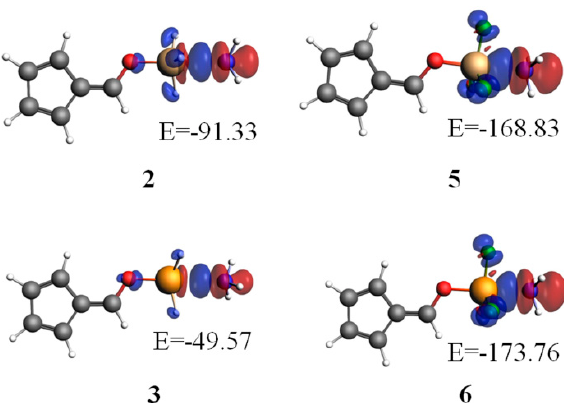
Figure 4. Plots of deformation densities of the pair-wise orbital interactions ( Δρ ) in 6-OTX 3 -fulvene ··· NH 3 (T = Si, Ge; X = H, F) at the PBED3/TZ2P//MP2/aug-cc-pVTZ level. The associated orbital interaction energies are given in kJ/mol. The color code of the charge flow is red → blue, and the isovalue for Δρ (r) is 0.002 a.u. Table 3. Charge transfer (CT, e) and second-order perturbation energies ( E (2) , kJ/mol) in the complexes.